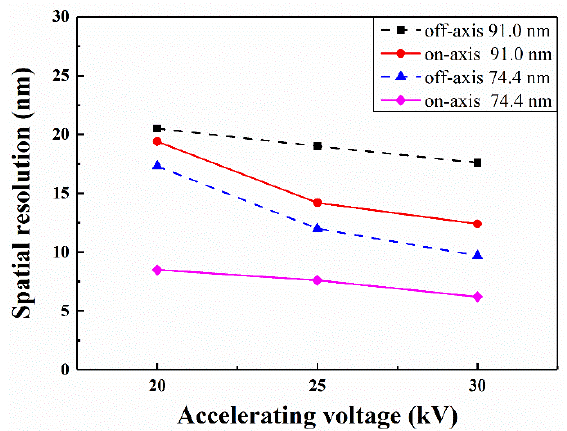
Figure 3. Spatial resolution of the on-axis and off-axis TKD methods as functions of the accelerating voltage at thicknesses of 91 and 74 nm.